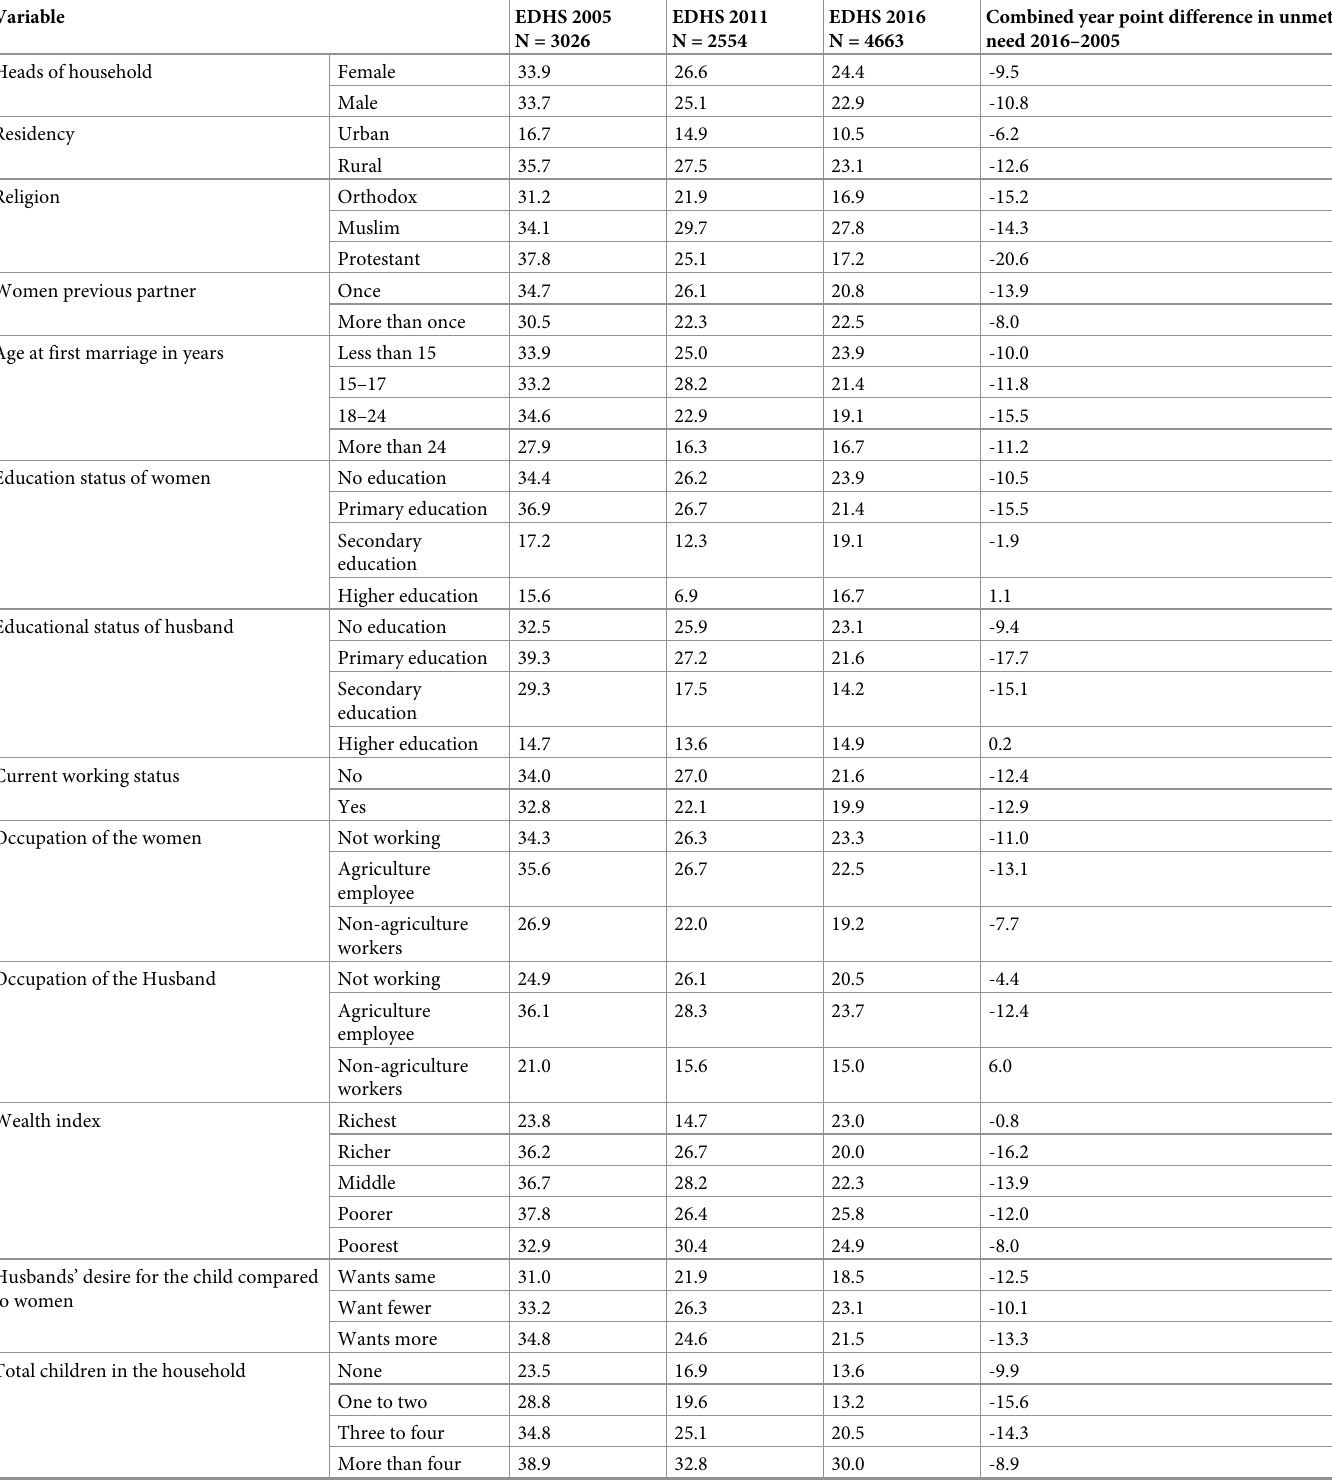
Table 3. Magnitude of unmet need for family planning among currently married women of reproductive age by selected characteristics in 2005, 2011, and 2016.